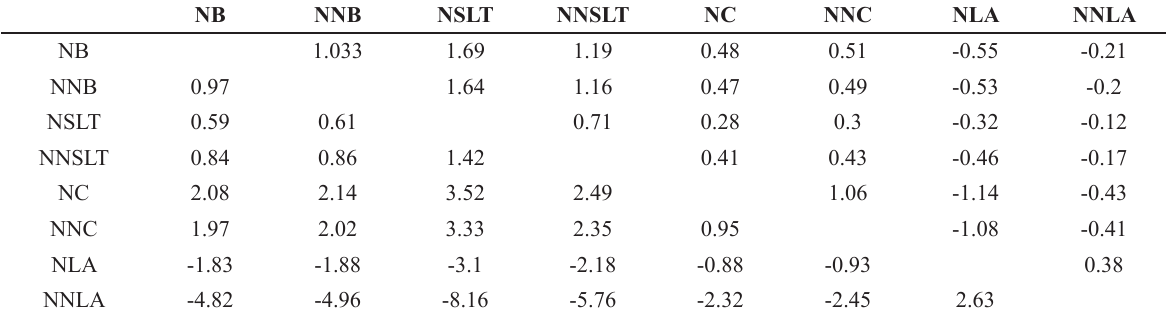
Prevalence ratios among the different groups of children